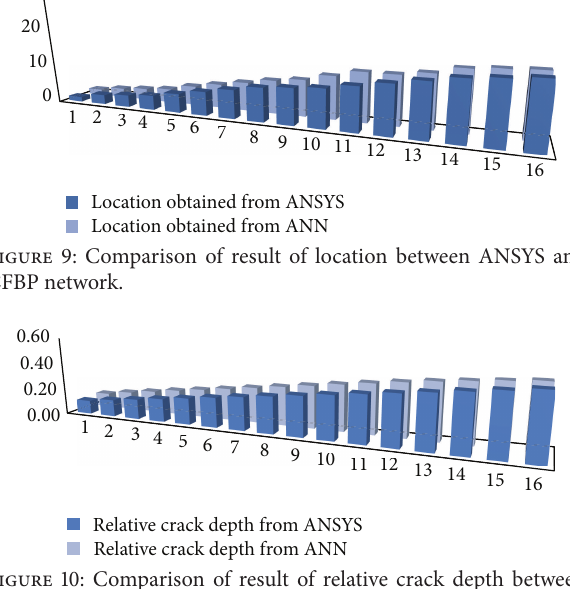
Figure 8 for the individual results